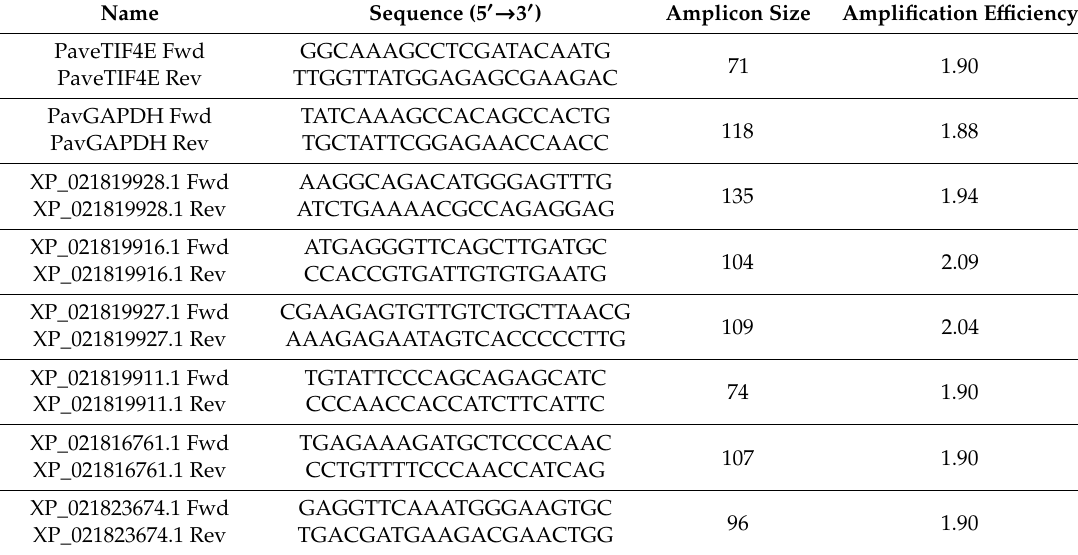
Table 2. List of primers with details of the sequences, amplicon sizes and amplification e ffi